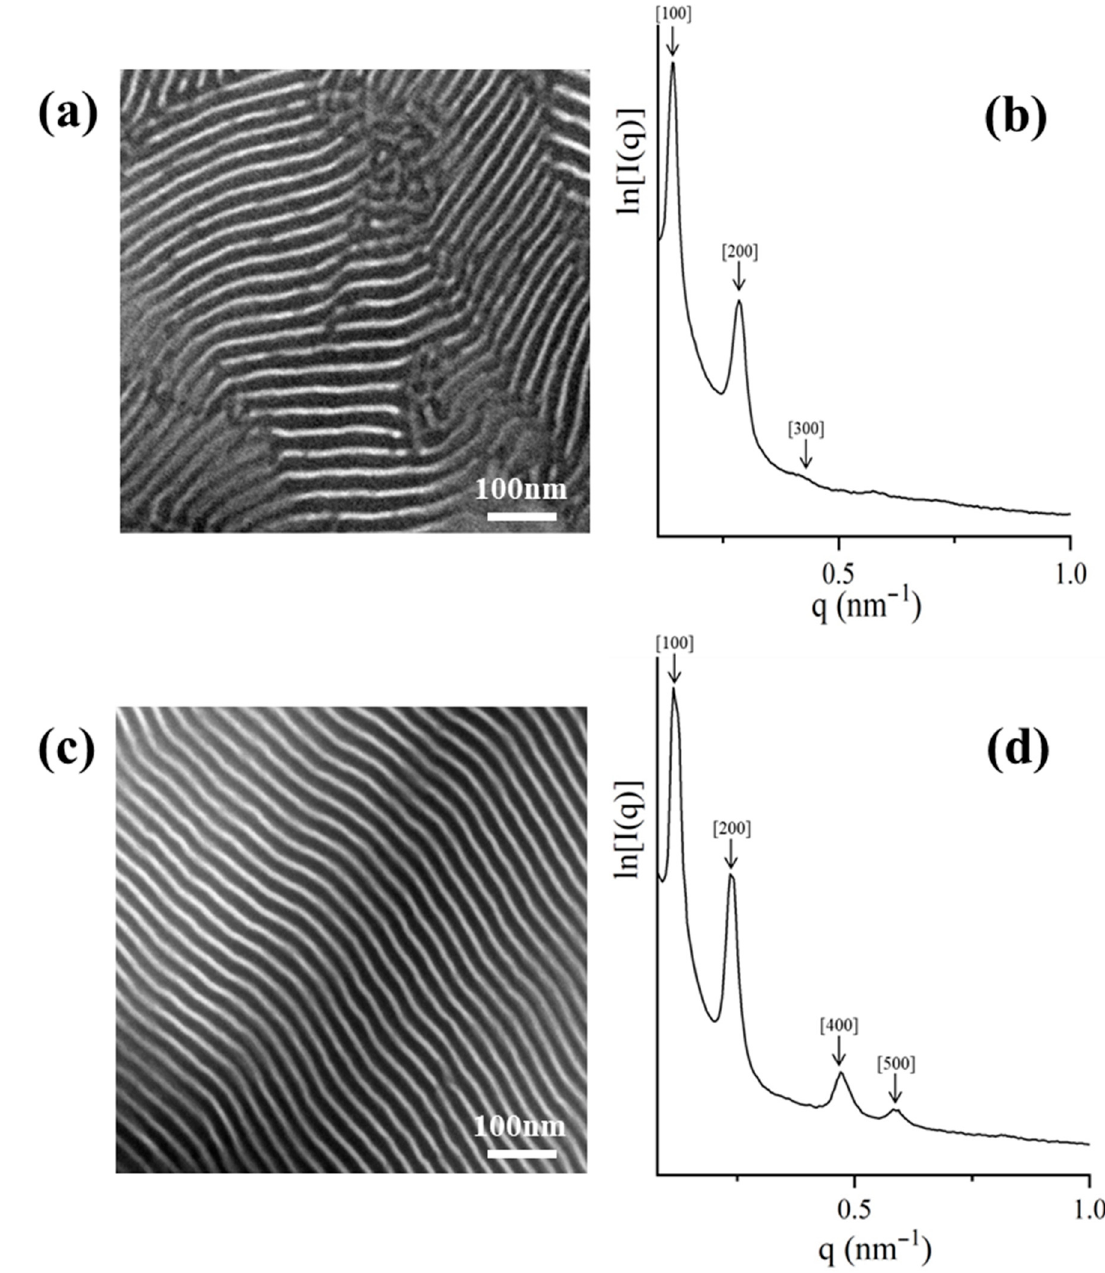
Figure 5. Bright-field TEM images of the dendritic final terpolymer [(PS)(PI)(PB)] 4 -B 4 core and the corresponding dendron where in both cases 2-phase contrast is clearly indicated ( a , c ) after staining with vapors of OsO 4 aqueous solution and their relevant 1D SAXS plots ( b , d ). In both cases, alternating lamellae domains are clearly observed in the TEM images and are verified by the observed peaks ratio at the 1D SAXS plots. In all TEM images white areas correspond to PS and dark to mixed PI and PB